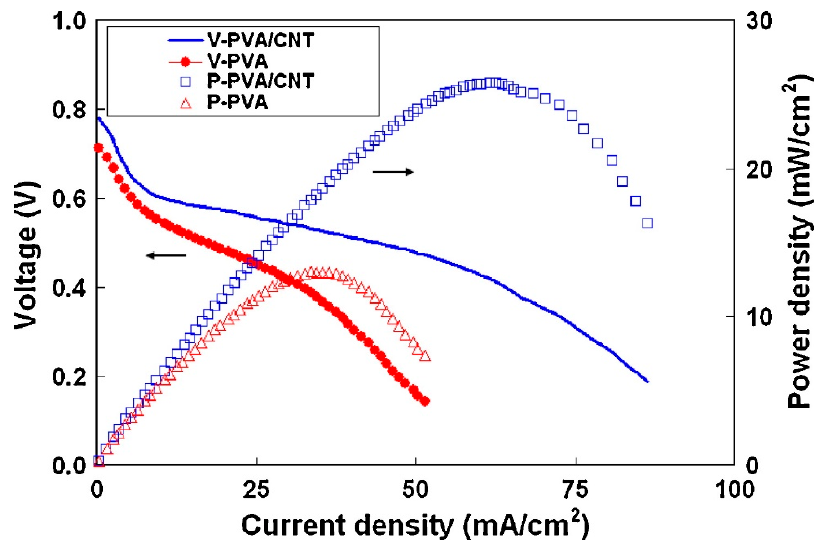
Figure 3. Effect of MWCNT addition in PVA on DMAFC performance at 30 °C (anode: 2 M MeOH in 6 M KOH, flow rate of 5 mL min − 1 ; cathode: humidified O 2 , flow rate of 100 mL min − 1 ). Reproduced with permission from Ref. [24].